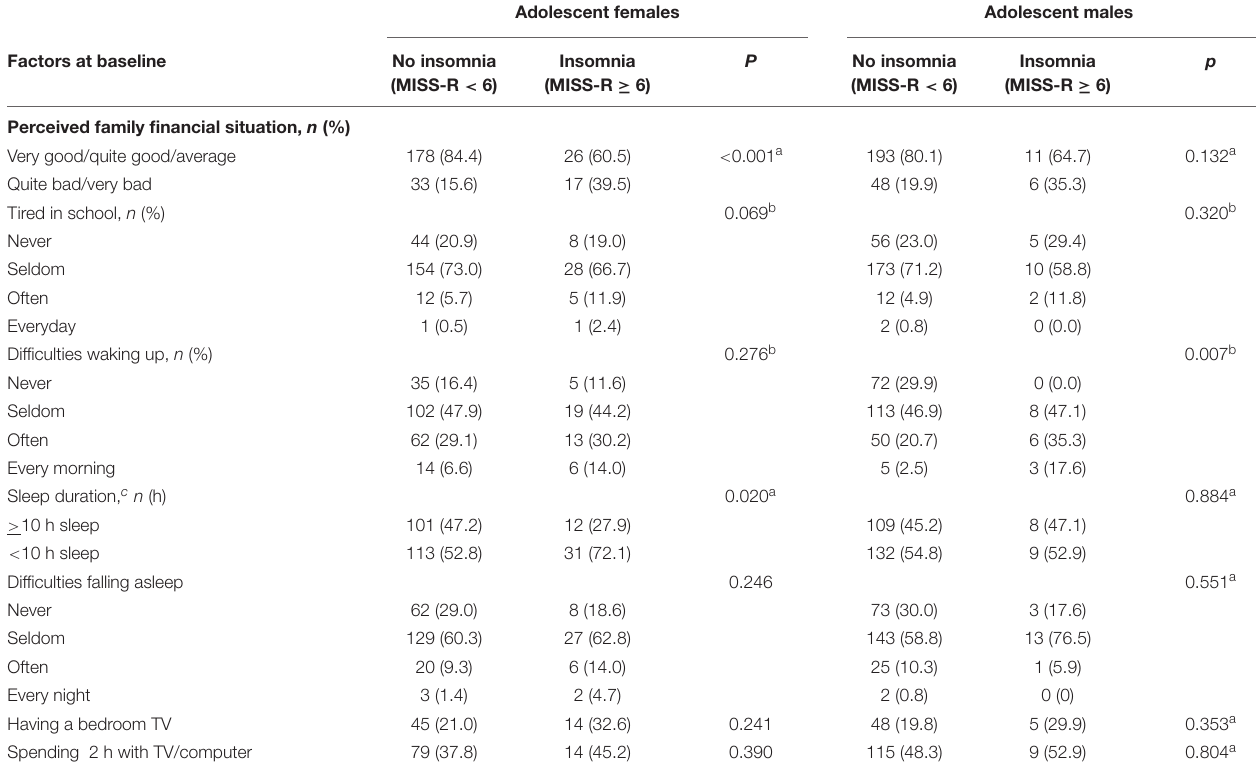
TABLE 1 | Bivariate analysis of associations of insomnia (MISS-R ≥ 6) at follow-up and factors at baseline. Adolescent females Adolescent males Factors at baseline